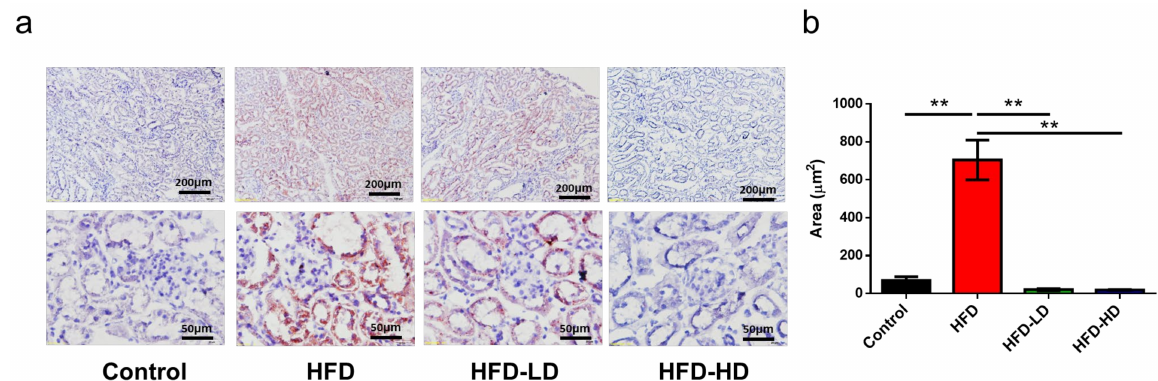
Figure 2. Empagliflozin attenuates lipid accumulation in the kidney of HFD mice. Six-week-old C57BL/6 male mice were assigned to the following groups: (1) CD, (2) HFD, (3) HFD + low-dose empagliflozin, or (4) HFD + high-dose empagliflozin for 12 weeks ( n = 6 in each group). ( a ) In Oil red O-stained images, HFD significantly increases lipid accumulation when compared with CD, while empagliflozin attenuates lipid deposition in the kidney of HFD mice in a dose-dependent manner. Scale bars at upper panel = 200 µ m, lower panel = 50 µ m. ( b ) The histograms represent mean ± standard error (SE). Statistical analysis was performed with one-way ANOVA. ** p < 0.01 vs. HFD in each group. HFD, high-fat diet; CD, control diet; LD, low-dose empagliflozin; HD, high-dose